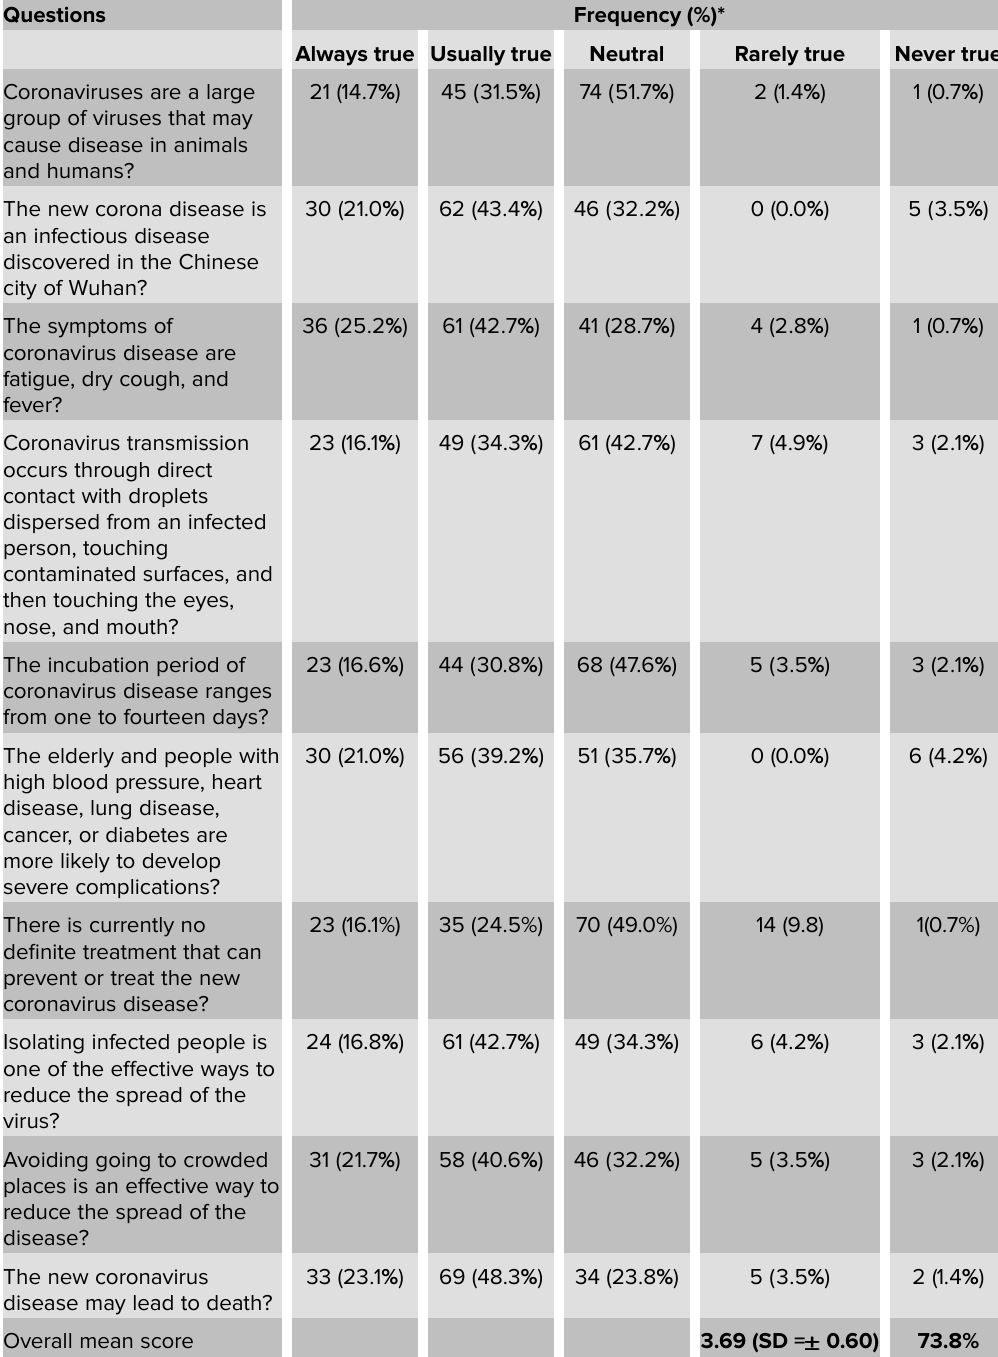
TABLE 2: Distribution of participants’ Knowledge regarding COVID-19 ( n =